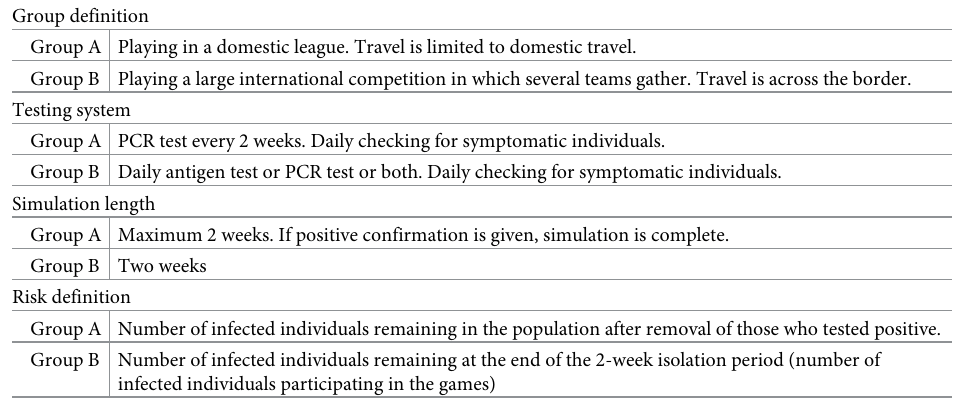
Table 1. Summary of information about